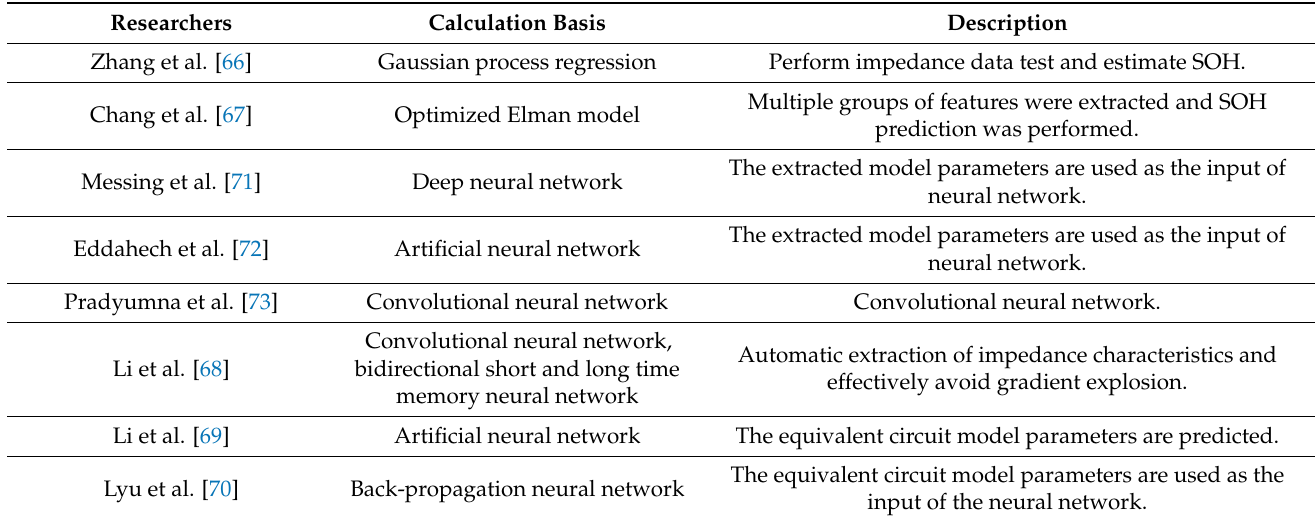
Table 3. Summary of SOH estimation for lithium-ion batteries based on machine